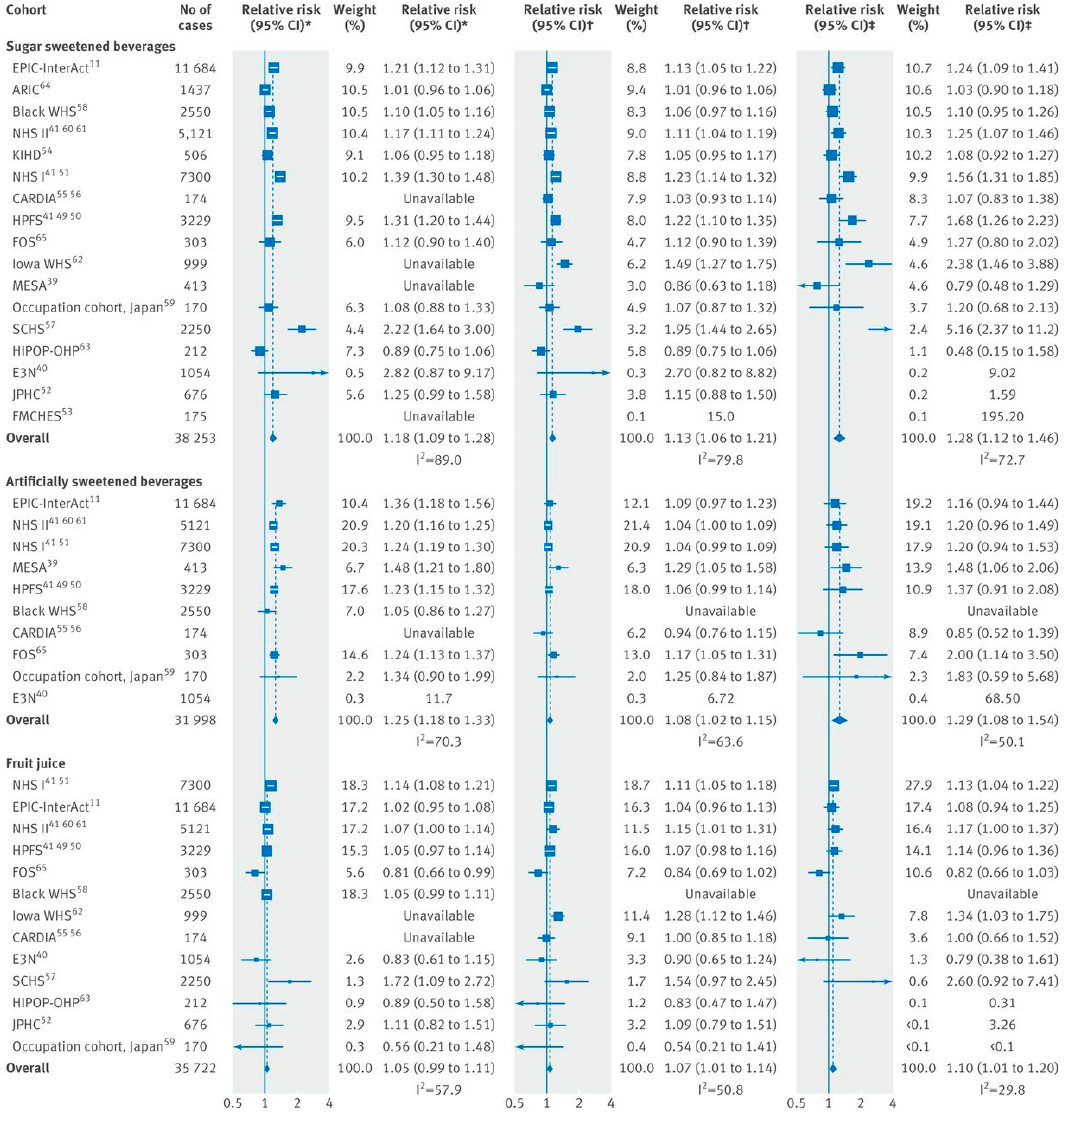
Figure 2. Prospective associations for an incremental increase in beverage consumption with incident type 2 diabetes (T2D): random effects meta-analysis. * Unadjusted for adiposity; † adjusted for adiposity; ‡ adjusted for adiposity and within person variation [54].